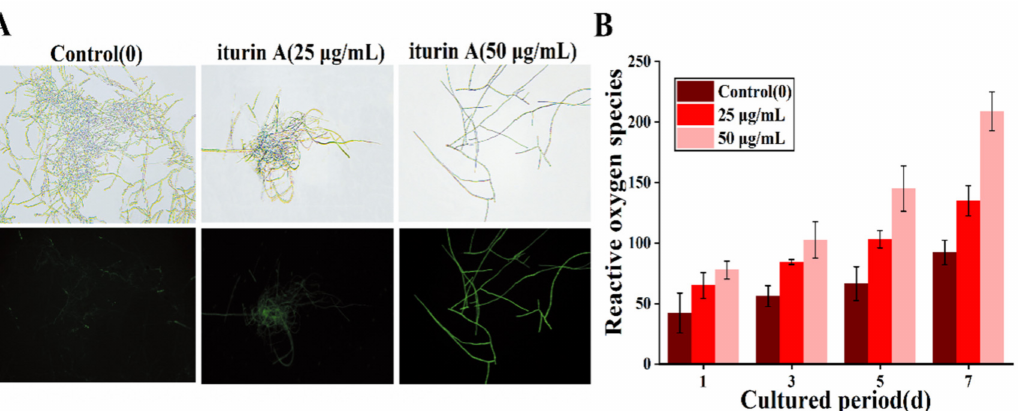
Figure 5. Effects of 25 and 50 µ g/mL iturin A on intracellular reactive oxygen species (ROS) in F. oxysporum as examined by biofluorescence microscopy ( A ) and fluorescence spectrophotometry ( B